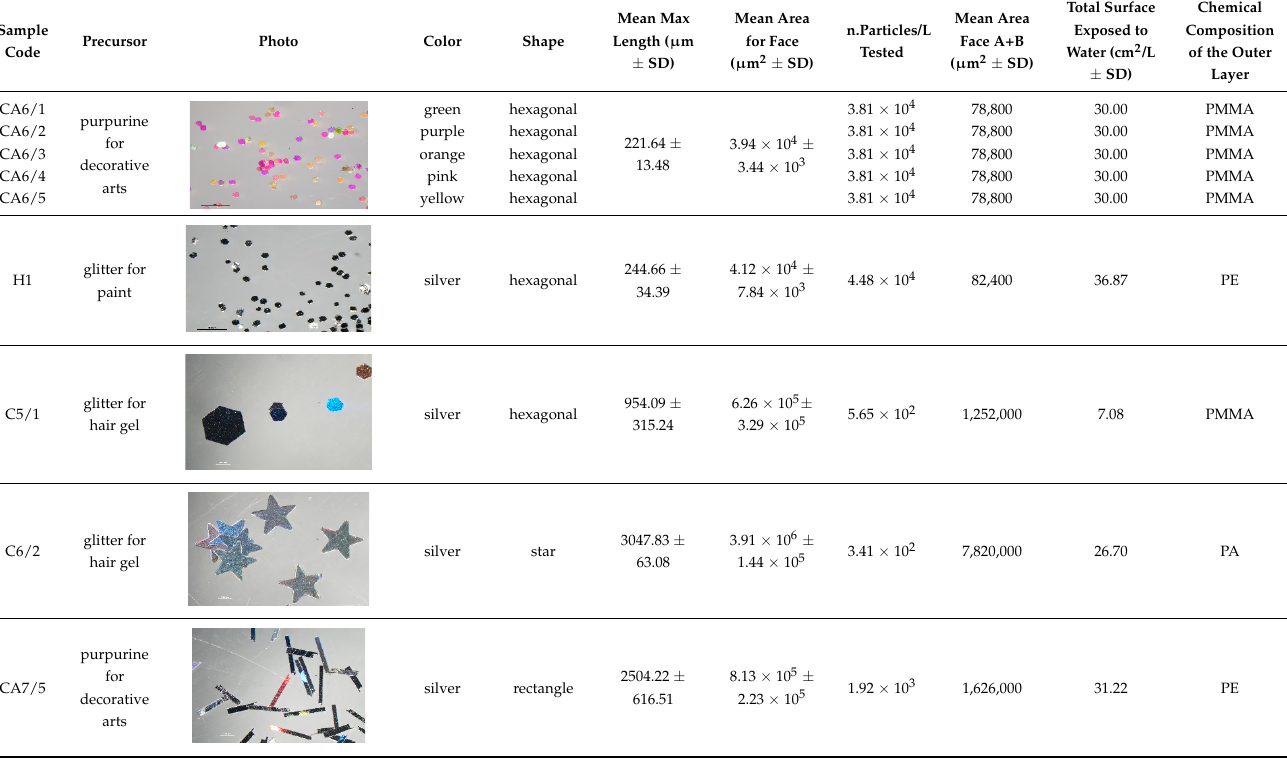
Table 1. Characteristics of the nine glitters used to prepare the leachates: sample code, precursor, stereomicroscopic images, shape, mean maximum length and area (expressed in μ m and μ m 2 ± standard deviation, respectively), number of particles tested, mean total area for each particle (face A + B), total surface area exposed to water for each type (number of particles * area face A + B, in μ m 2 ± SD) and chemical composition of the outer layer. PMMA = polymethyl methacrylate; PE = polyethylene; PA = polyamide.